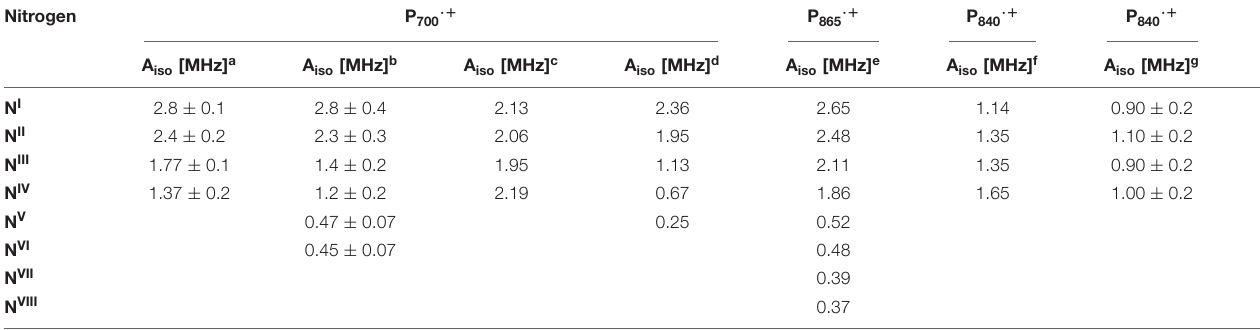
TABLE 2 | Experimental 14 N isotropic hyperfine couplings of the nitrogen atoms of P 700 ·+ , P 865 ·+ , and P 840 ·+ of the GsbRC and Cab . RC.